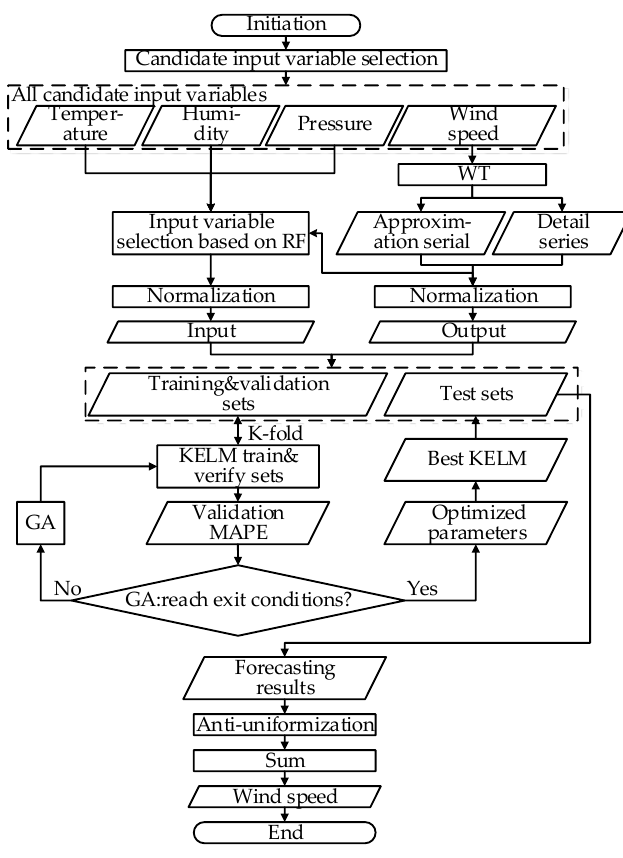
Figure 2. Flowchart of the WT-RF-KELM-GA model.